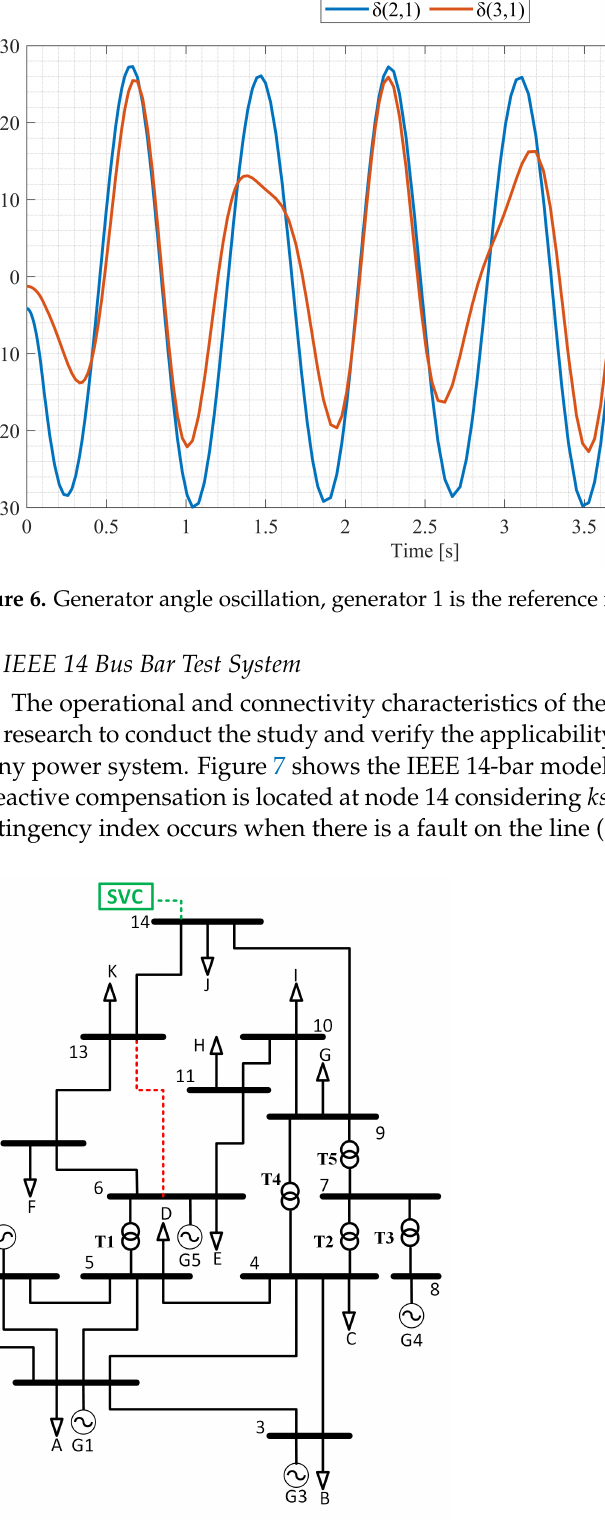
Figure 7. Location of SVC in the 14-bus bar IEEE